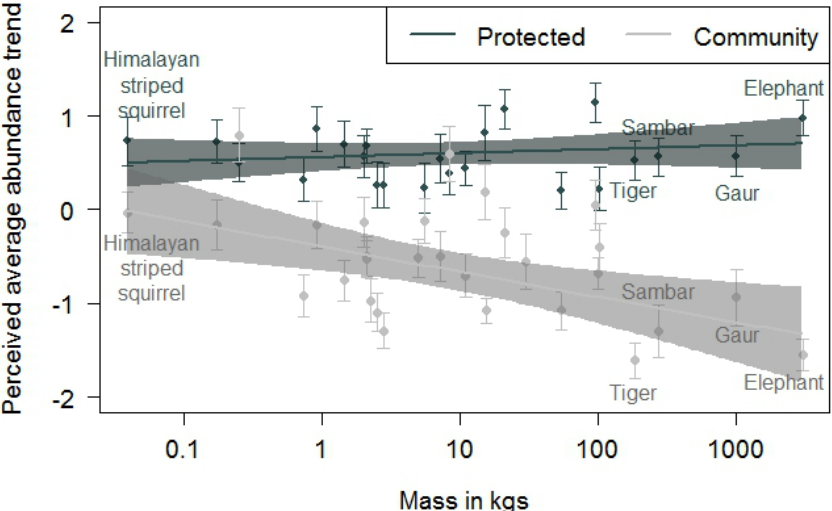
Figure 5. Average scores for perceived species trends based on key informant interviews. The black dots are means and standard errors for each species in Pakke Tiger Reserve, whereas the grey dots are means and standard errors for each species in the adjacent community-managed lands. The solid lines show the fitted ordinary least-squared prediction for species as a function of increasing body mass, and the shaded polygons are the 95% confidence interval. Note that the x-axis is on a log scale. Community-managed lands showed a negative perceived abundance trend with increasing body mass.